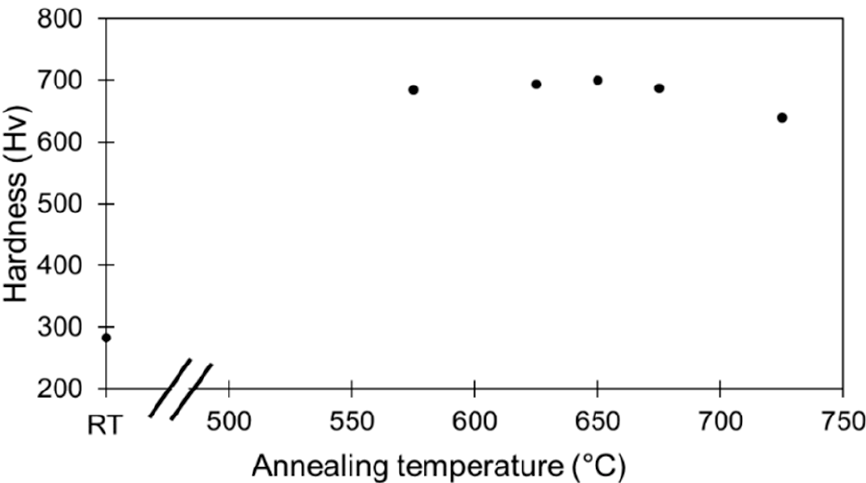
Figure 5. Evolution of mean microhardness of 85%-rolled sample with annealing temperatures for 1h annealing. Error bar is smaller or about marker size.